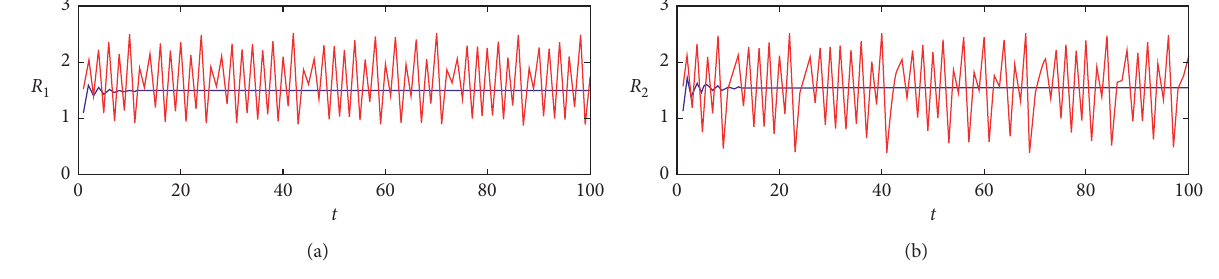
Figure 15: Effects of control factor k on R